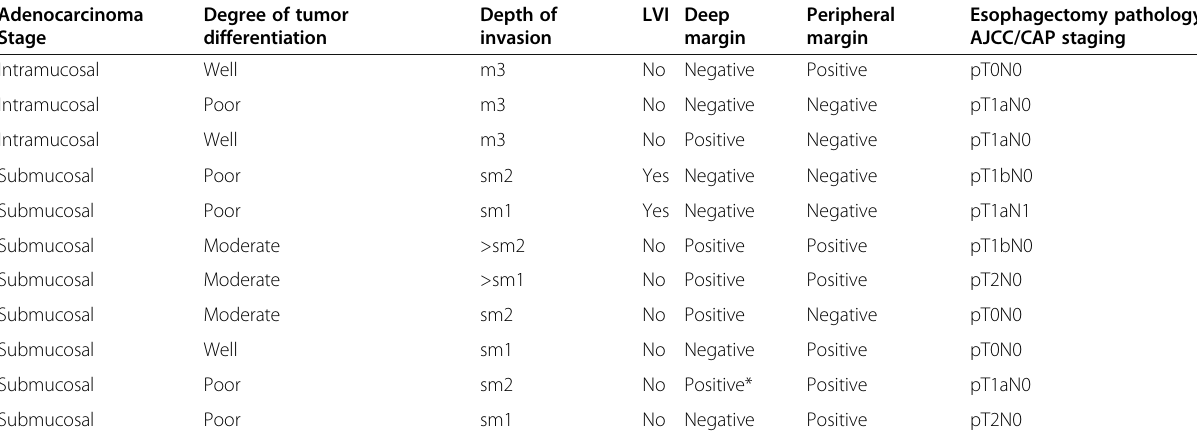
Table 3 Patients who underwent esophagectomy ( n = 11) Adenocarcinoma Stage